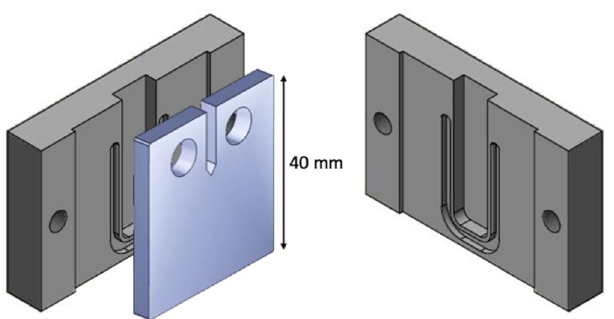
Figure 1. CT specimen and sample holders for the incubation with enzyme-buffer solution. The CT specimen is placed between two perfectly fitting parts, and tightly secured with screws. The indentations are filled either with buffer or enzyme-buffer solution. To avoid leakage of the solutions, U-shaped seals are fixed between specimen and sample holder. The setup ensures the total coverage of the specimen with solution within the expected crack propagation direction.